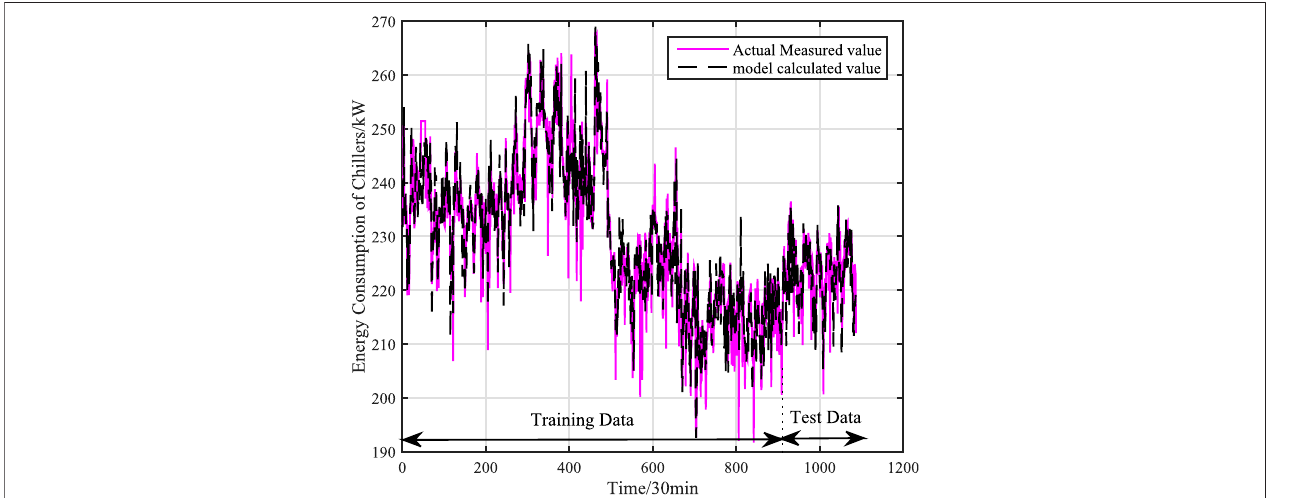
FIGURE 6 | Training and test results of mechanism model under single working condition (working condition 2).